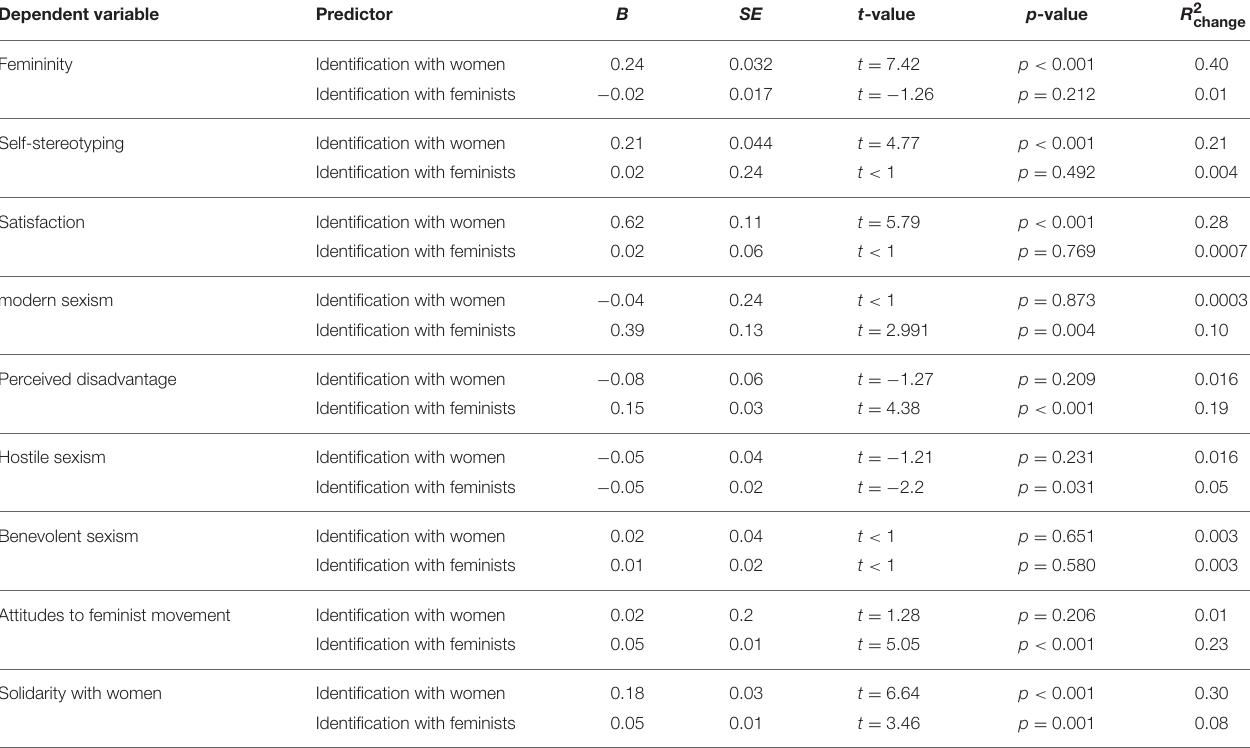
TABLE 2 | Attitudes predicted by identification with women, and identification with feminists in Study 1. Dependent